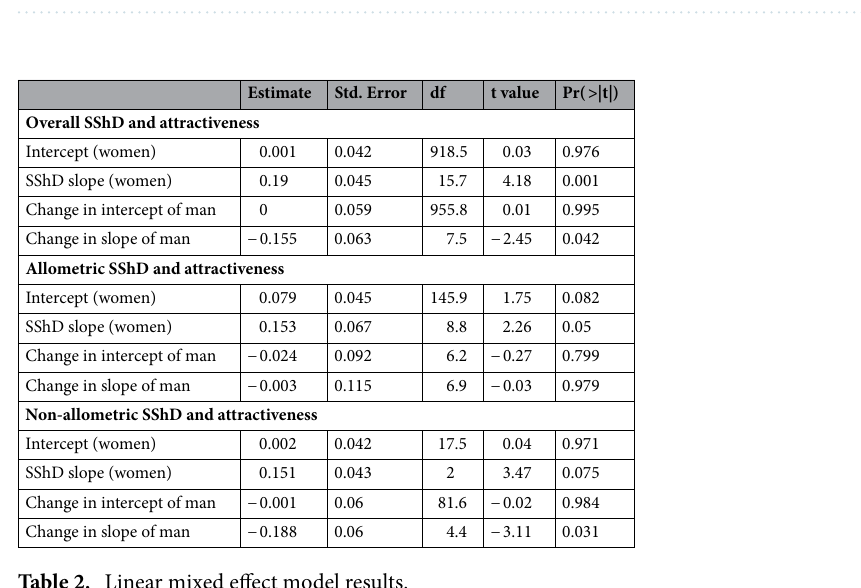
Table 2. Linear mixed effect model results.